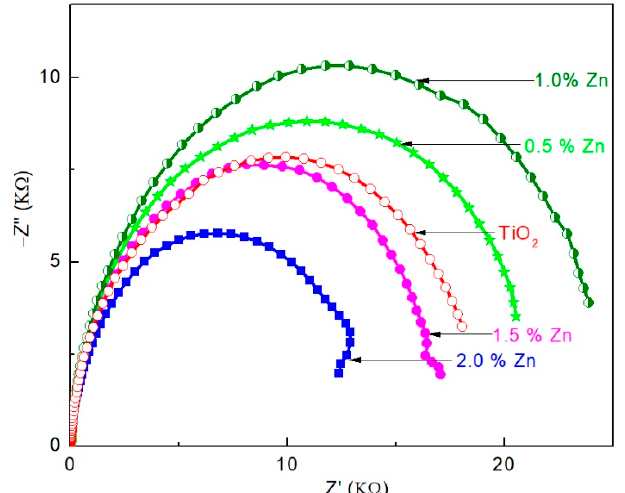
Figure 5. Nyquist plot of DSSCs with undoped, 0.5, 1.0, 1.5, and 2.0 mol% Zn-doped TiO 2 in dark.